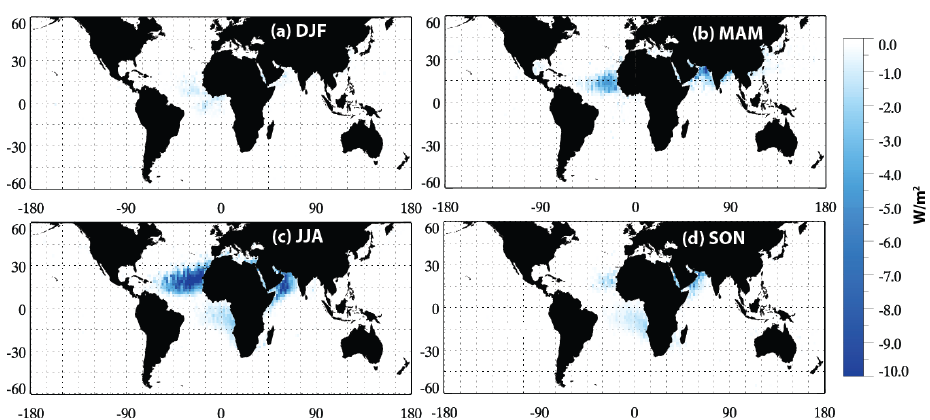
Figure 6. 8-year seasonal mean diurnally averaged shortwave cloudy-sky DRE at surface, using the CALIOP smoke and OBS dust aerosol models. The ACA AOT in the computation is from the CALIOP operational product without any adjustment.